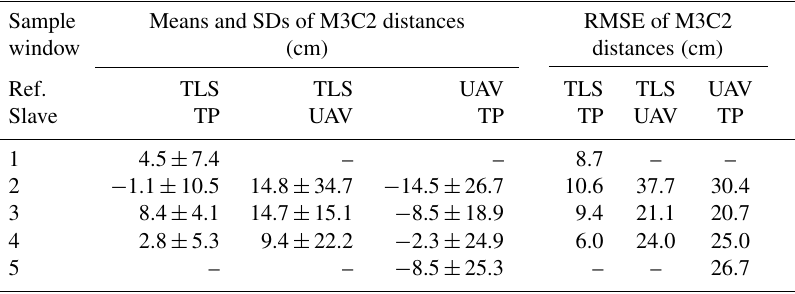
Table 3. Statistics on distances between point clouds computed on the basis of the M3C2 algorithm, showing mean, standard deviation and root mean square error (RMSE) of each point cloud pair. UAV refers to UAV photogrammetry, TP to terrestrial photogrammetry and TLS to terrestrial laser scanning. Ref. stands for reference and “–” means no comparison was